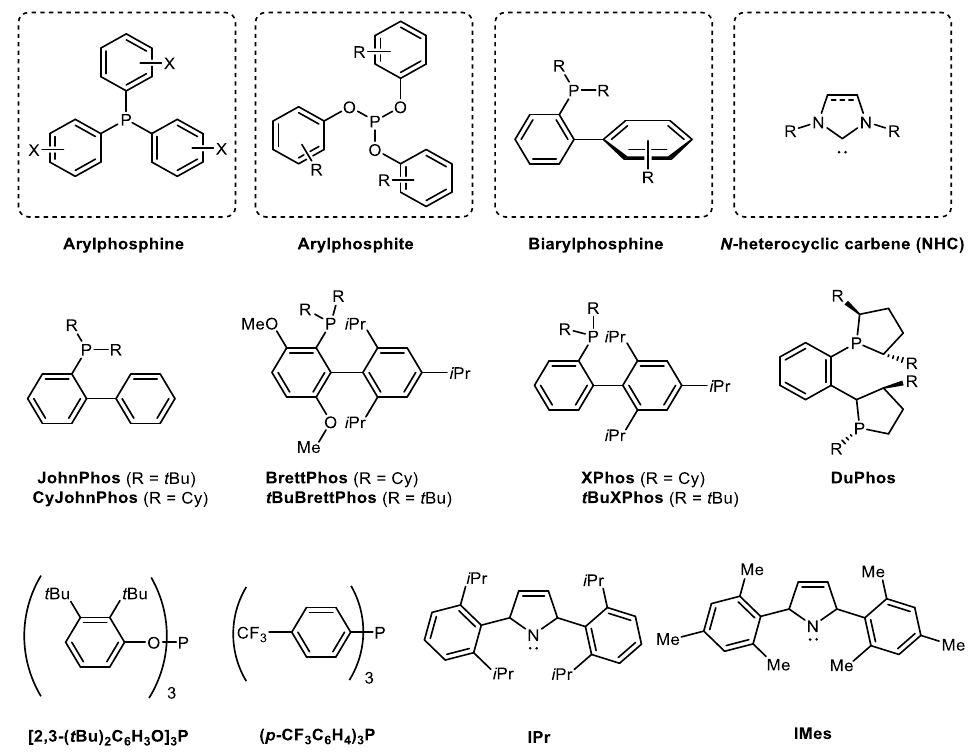
Figure 3. Commonly used ligands in gold(I)-catalyzed four-carbon ring systems